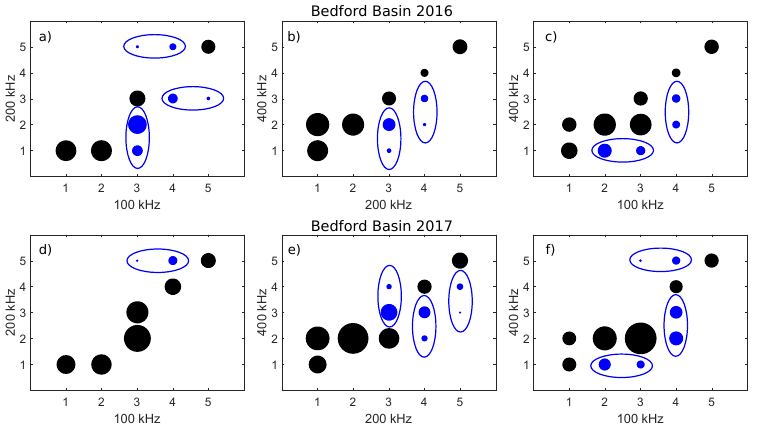
Figure 10. Matching matrix between the ACs of ( a , d ) 100 and 200, ( b , e ) 200 and 400, and ( c , f ) 100 and 400kHz for the Bedford Basin. The size of the circle represents the number of the AC combination that occur in the survey area. The black circles indicate the significant AC combinations where each AC per frequency is considered individually (the first part of Step 3) and the pairs of blue circles represent AC combinations where neighboring classes of one frequency are considered together (the second part of Step 3). To obtain theses plots, Steps 2 and 3 as described in Section 3.4 are applied.